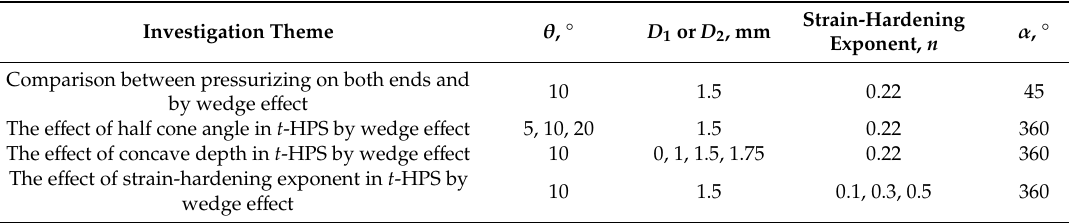
Table 1. Simulation variables and parameters; each line in the table indicates the simulation conditions to investigate the e ff ect of one variable on strain distribution (with underlined alternations of the variable values), with the other variables are set to constant for the simulation.